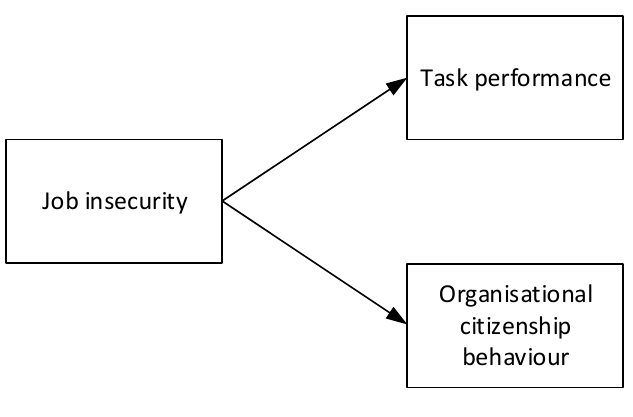
Figure 1. Theoretical model.